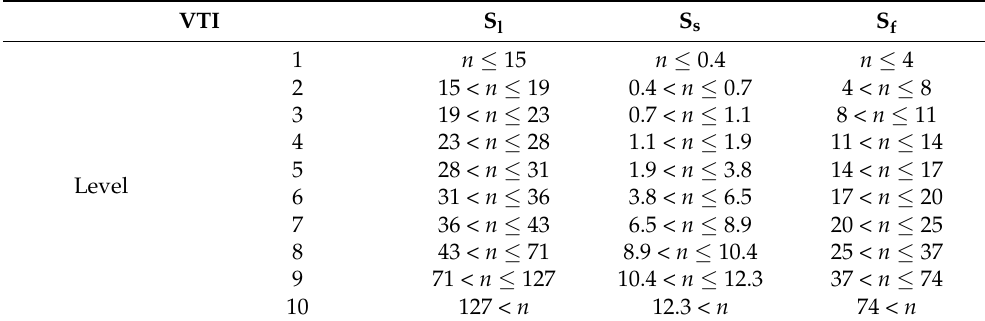
Table 8. VTI level settings considering LOA, SOG, and frequency of passing ships in Korean coastal waters.